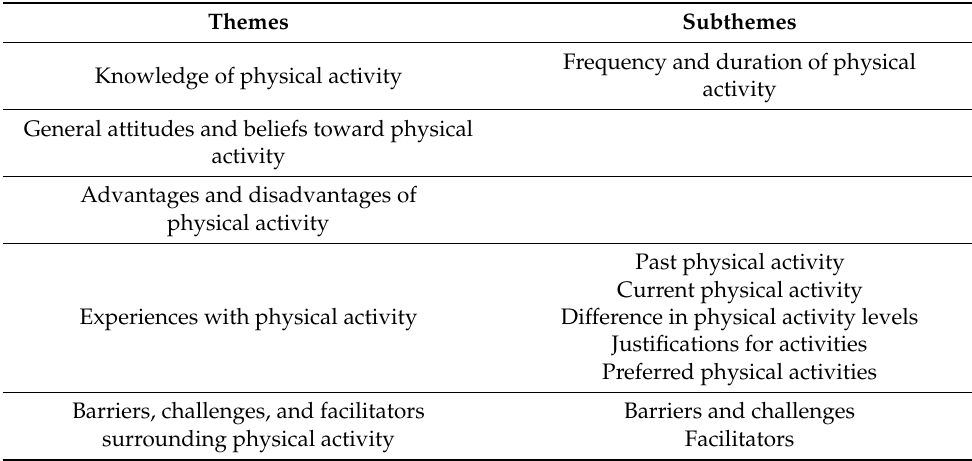
Table 2. Table of themes drawn from the